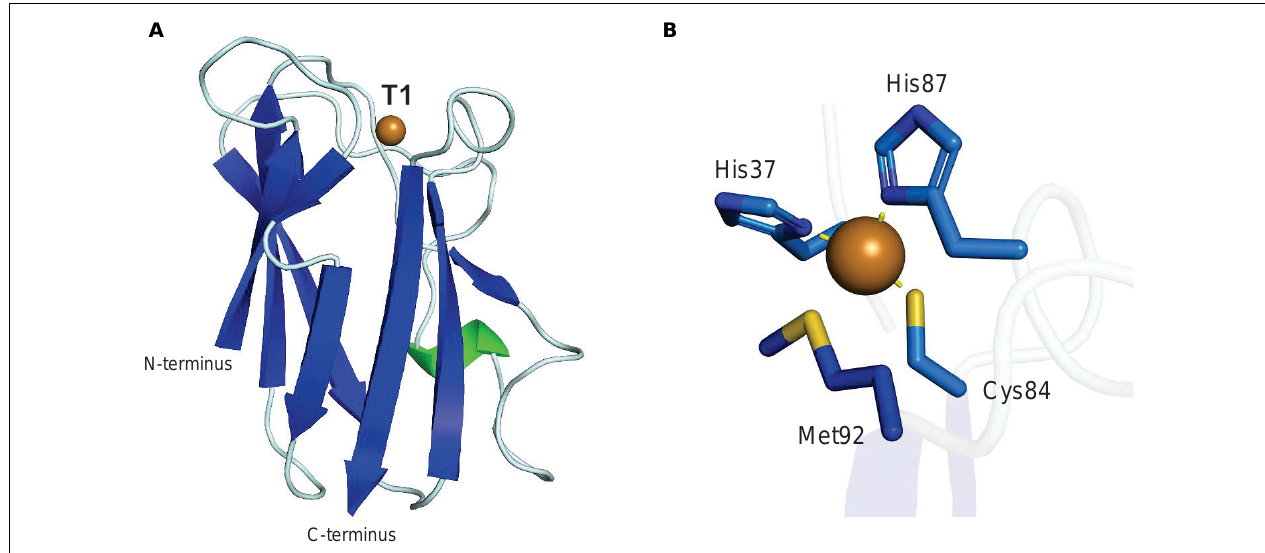
FIGURE 8 | Structure of a plant plastocyanin. (A) Protein structure of poplar plastocyanin (PDB: 1PLC) (Guss et al., 1992). (B) T1 copper center of poplar plastocyanin. In panels (A,B) , α -helices are highlighted in green, β -sheets are highlighted in blue. Copper atoms are shown as brown